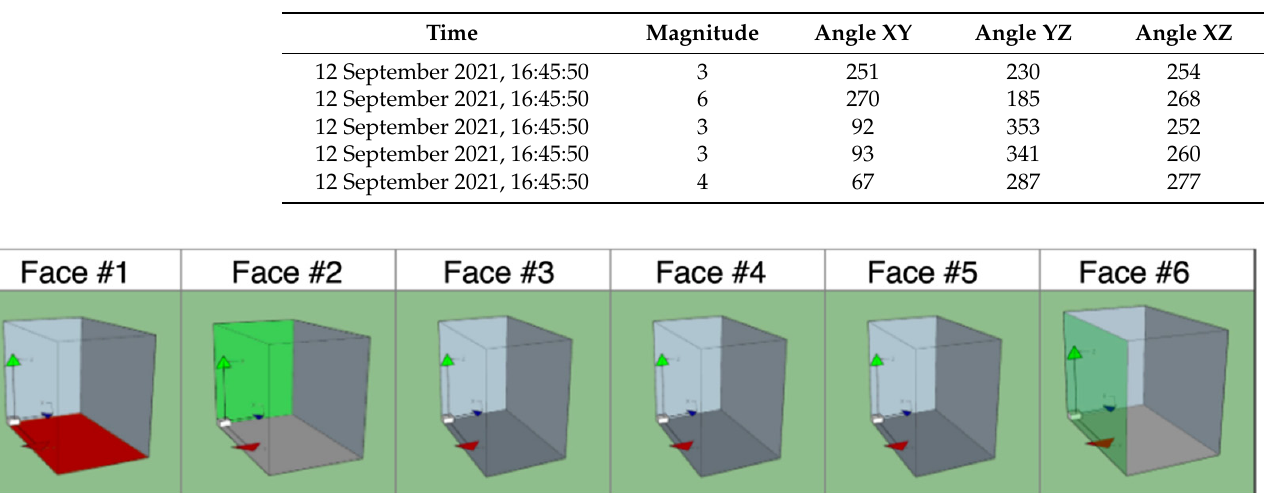
Table 5. Report of the five most recent shocks occurred.